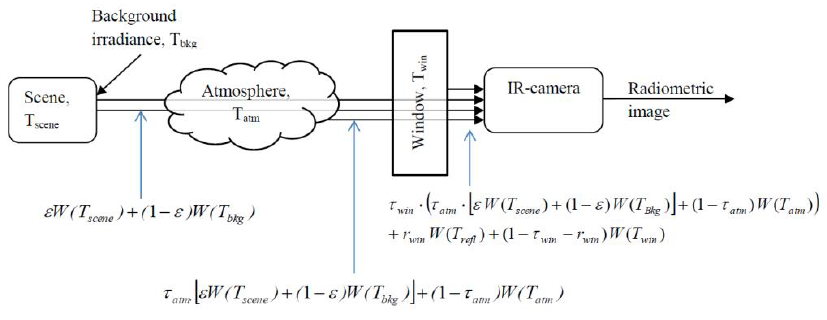
Figure 3. Principles of radiation measurement [26,27].